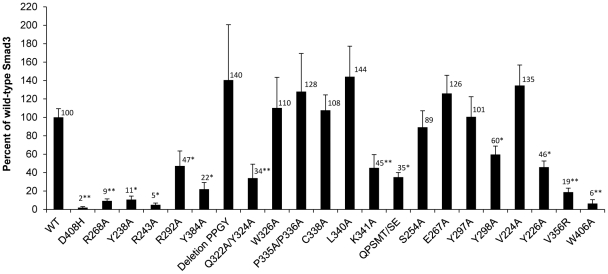
Rescue of TGF-β signaling in Smad3 deficient JEG-3 cells by wild-type and mutant Renilla-Smad3 fusion proteins.JEG-3 cells were transfected with plasmids for the Smad3-dependent firefly luciferase reporter gene SBE12-luciferase [97], the pCMV5 Renilla luciferase plasmid encoding wild-type or mutant Smad3 and a plasmid encoding beta-galactosidase that was used to normalize for differences in transfection efficiency. After 24 hours of 100 pM TGF-β, cell lysates were analyzed for luciferase and beta-galactosidase activities. Total Renilla luciferase activity was measured in each transfected cell lysate to confirm comparable expression levels of Renilla-Smad3 fusion proteins. The TGF-β-induced firefly luciferase activity for each mutant was normalized to the activity provided by wild-type Smad3 (100%). The average of the data from a minimum of six independent transfections with each Smad3 variant are shown. The levels of reporter gene expression for cells transfected with wild-type and mutant Smad3 were compared using a permutation test that combined the results of the replicate experiments. For mutants with reduced reporter gene activity, P-values (corrected for multiple comparisons) less than 0.02 (*) and less than 0.001 (**) are indicated. The activity observed with Smad3 D408H was indistinguishable from the activity of JEG-3 cells without any exogenous Smad3. Most of the Smad3 mutants that altered binding to Smad4 (Table 2) provided reduced rescue of Smad3 signaling. Some of the mutations that retained Smad4 binding also provided reduced rescue of Smad3 signaling but other Smad3 mutations that had specific defects in protein binding (Table 3) were as effective as wild-type Smad3 for restoring signaling in the JEG-3 cells.